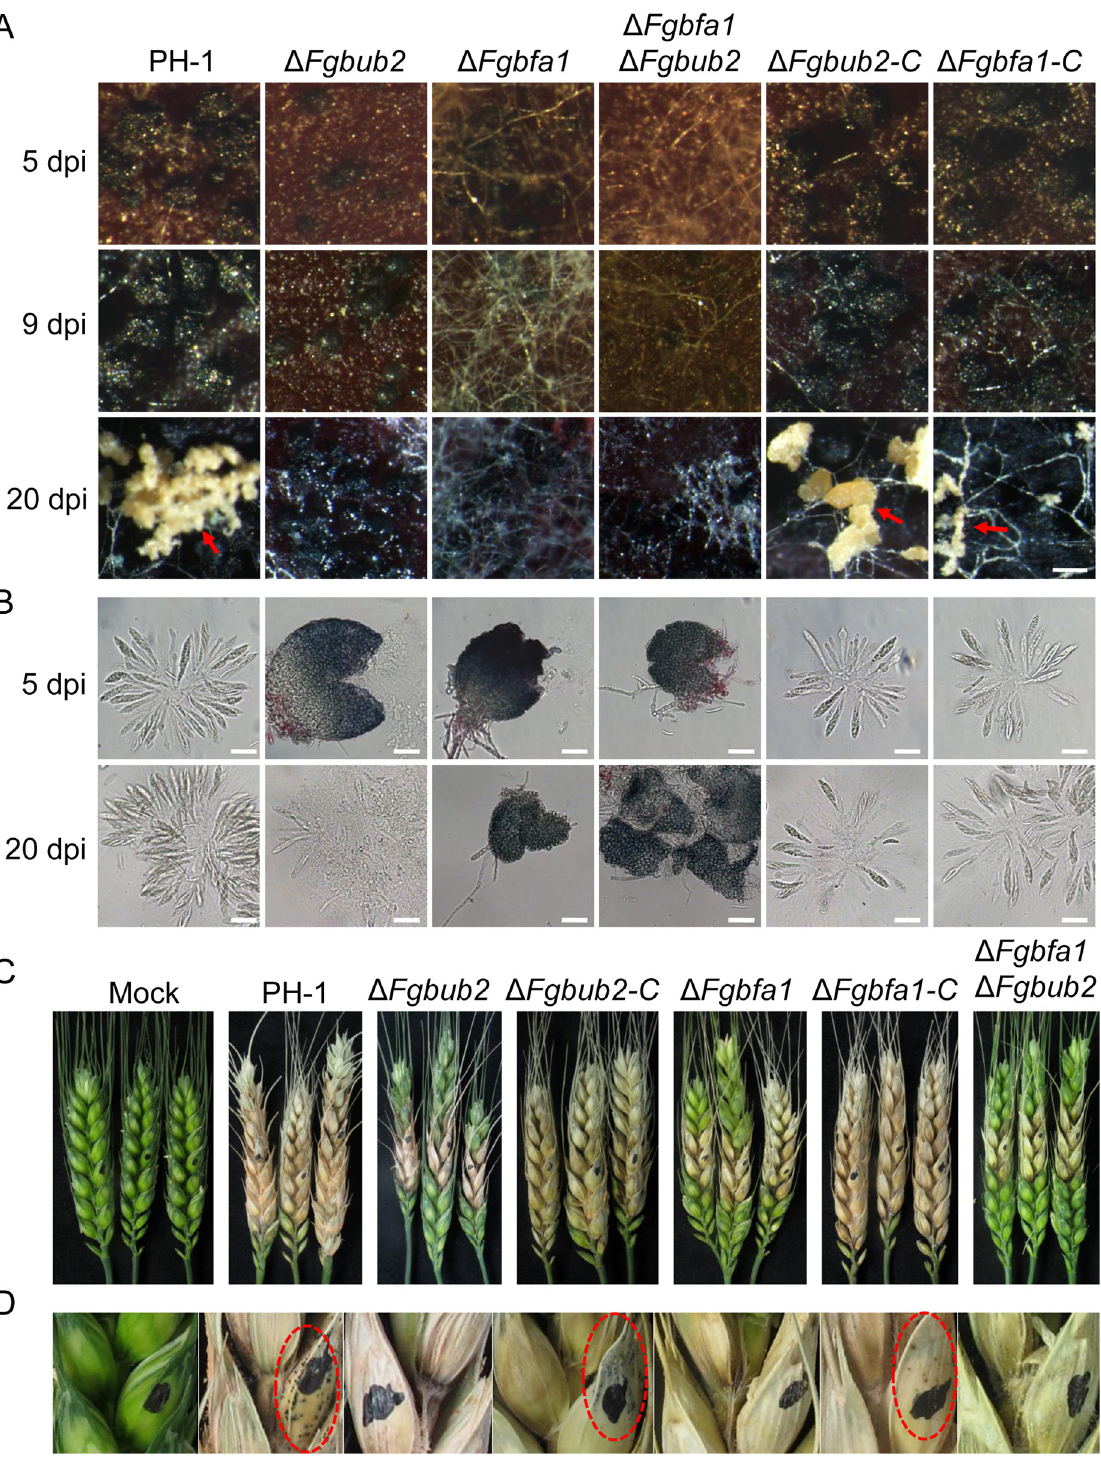
Fig 7. Effects of FgBUB2 and FgBFA1 deletions on sexual reproduction and pathogenicity of F. graminearum . (A) The PH-1, Δ Fgbub2 , Δ Fgbfa1 , Δ Fgbfa1 Δ Fgbub2 , Δ Fgbub2 -C and Δ Fgbfa1 -C strains were examined for perithecia and cirrhus production on carrot agar medium at 5, 9 and 20 dpi (day post-inoculation). Bar = 200 μ m. (B) Asci and ascospores formed by PH-1, Δ Fgbub2 -C and Δ Fgbfa1 -C strains. The Δ Fgbub2 , Δ Fgbfa1 and Δ Fgbfa1 Δ Fgbub2 mutants failed to produce mature ascospores, Bars = 50 μ m. Photographs were taken at 5 and 20 dpi. (C) Pathogenicity of the wild type PH-1, indicated mutants and complemented strains on wheat heads. Infected wheat heads